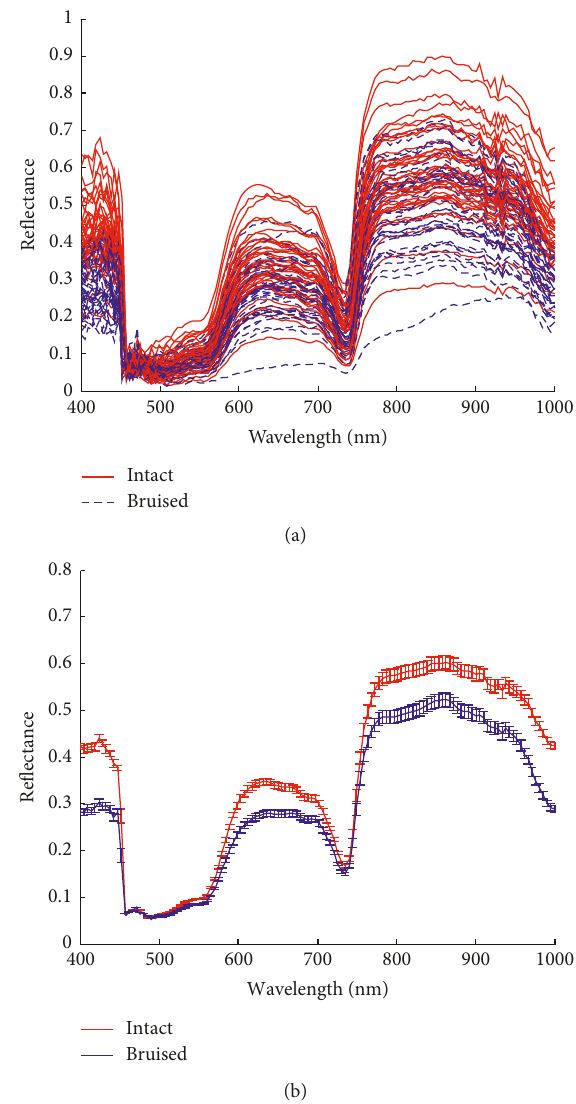
Figure 4: Average reflectance spectra of the bruised and intact Korla pear surfaces. (a) The original reflectance spectra. (b) The mean and variance of the